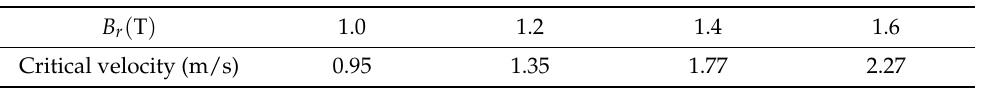
Table 2. Critical velocity of magnetic particles (d = 23 µ m) with 80% capture probability under different remanence conditions.